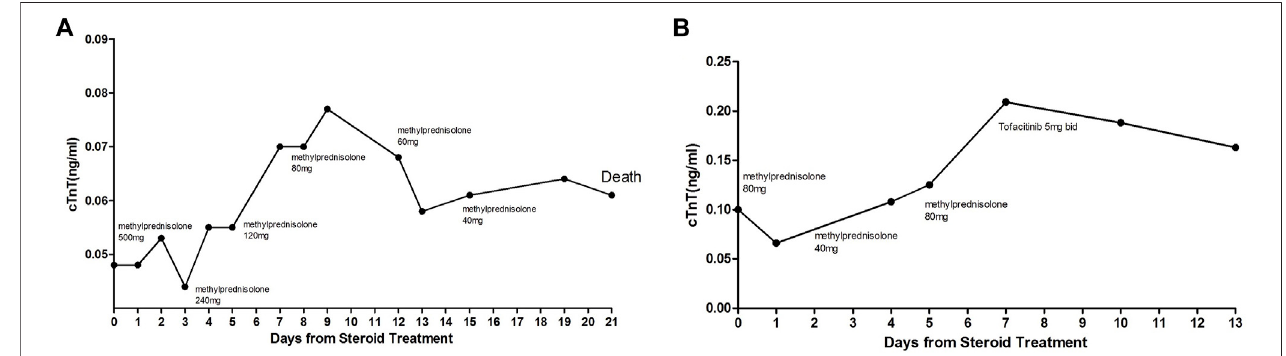
FIGURE 4 | Two cases from the corticosteroid-resistant group. Initial cTnT levels were less than 0.1 ng/mL; however, cTnT levels rebounded signi fi cantly during corticosteroid tapering.